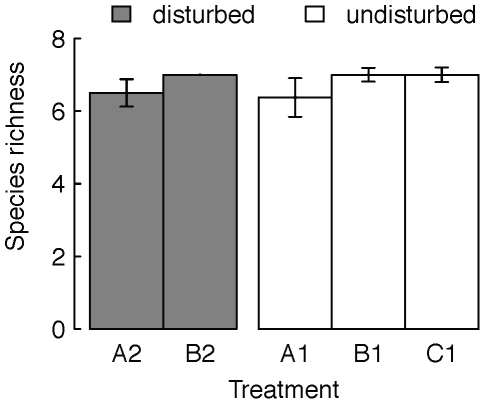
Mean species richness at the first sampling (32 days).Mean species richness (±se) within single communities in undisturbed and disturbed patches (white and grey bars respectively). A1 and A2 were isolated patches, while B1, B2 and C1 were connected patches (see also Fig. 1 and 2).